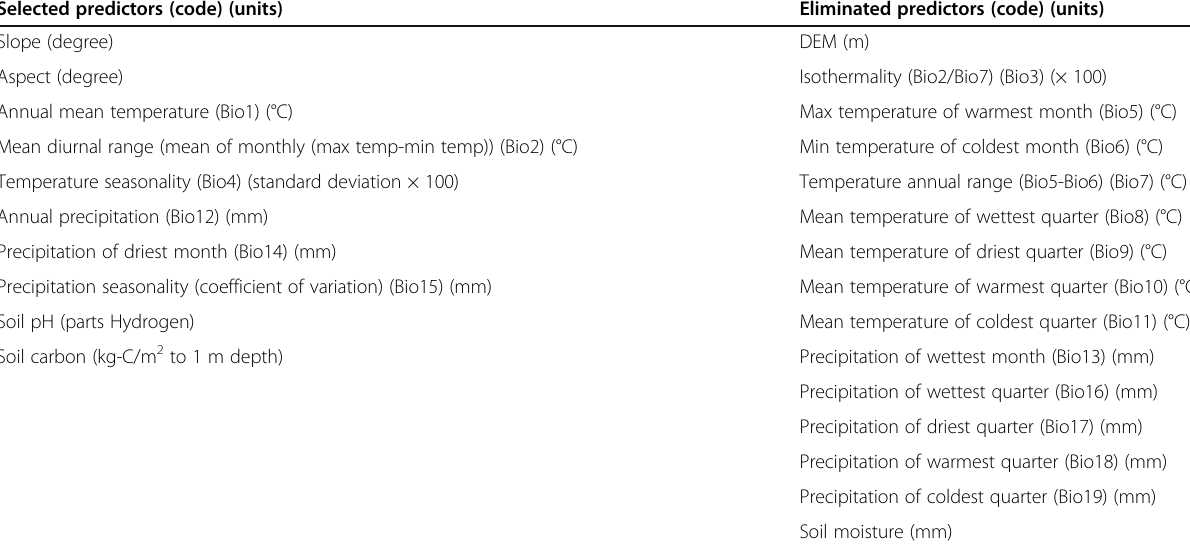
Table 2 Environmental predictors selected and eliminated in model building after correlation analysis. Eliminated predictors are highly correlated variables (Pearson ’ s | r | >